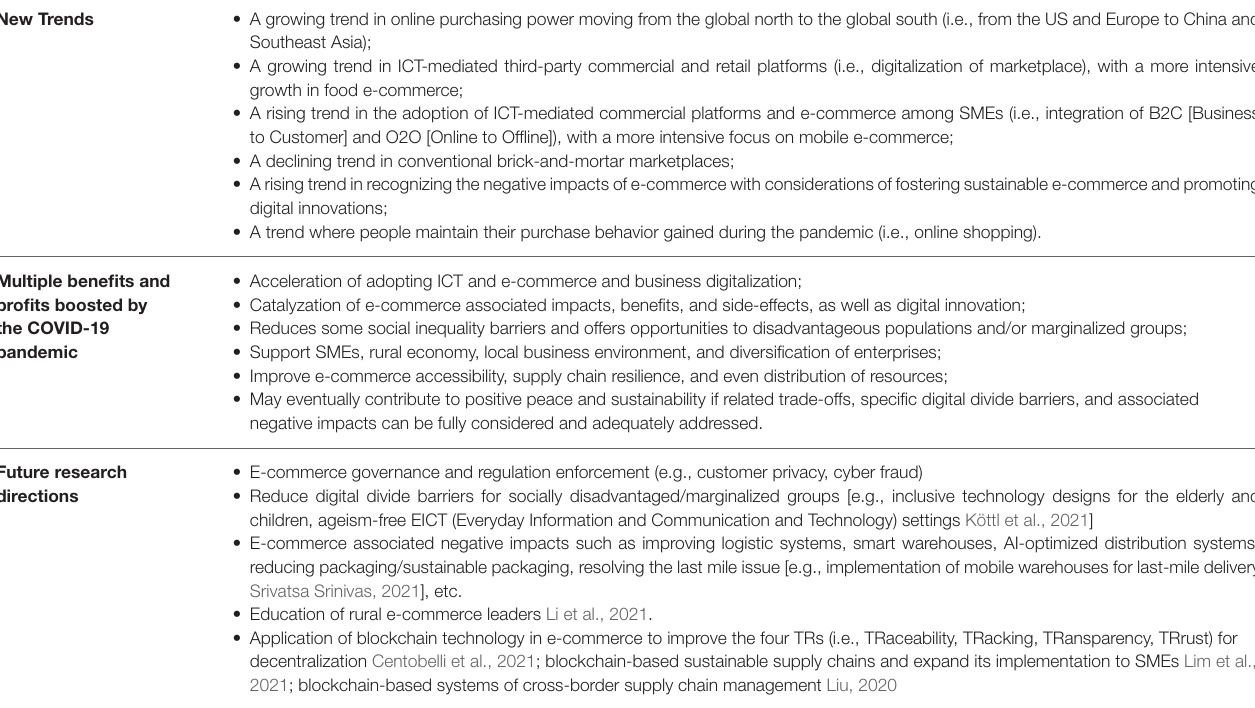
TABLE 1 | Summary of findings related to new trends, multiple benefits and profits, and future research